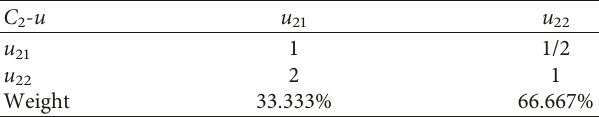
Table 11: Judgement matrix of the rule layer to the environmental conditions ( C 2 - u ).